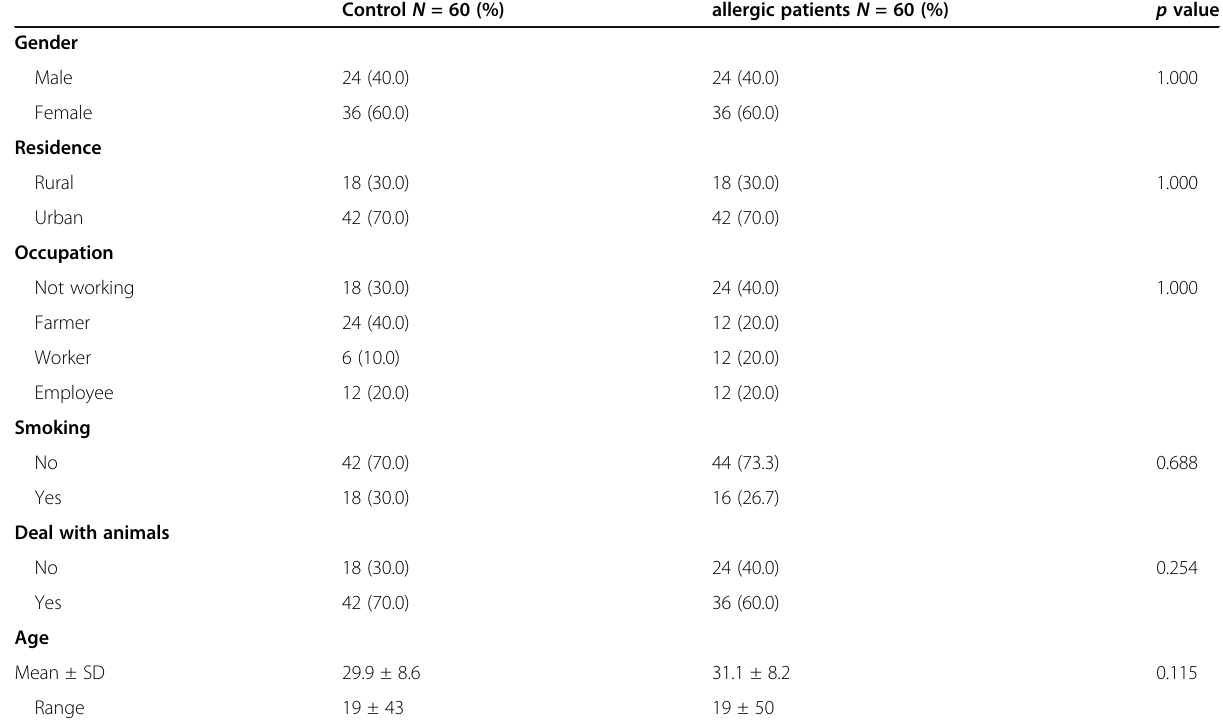
Table 2 Comparison between dust mites' allergic patients and controls regarding demographic characteristics Control N = 60